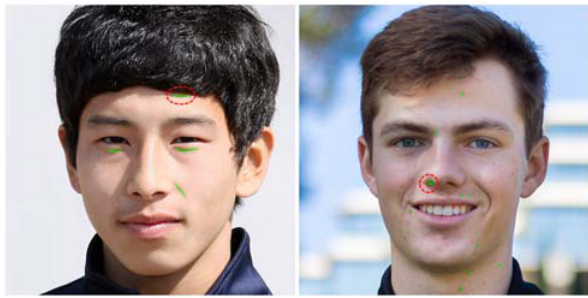
Figure 4. Examples of false detection on non ‐ facial areas.